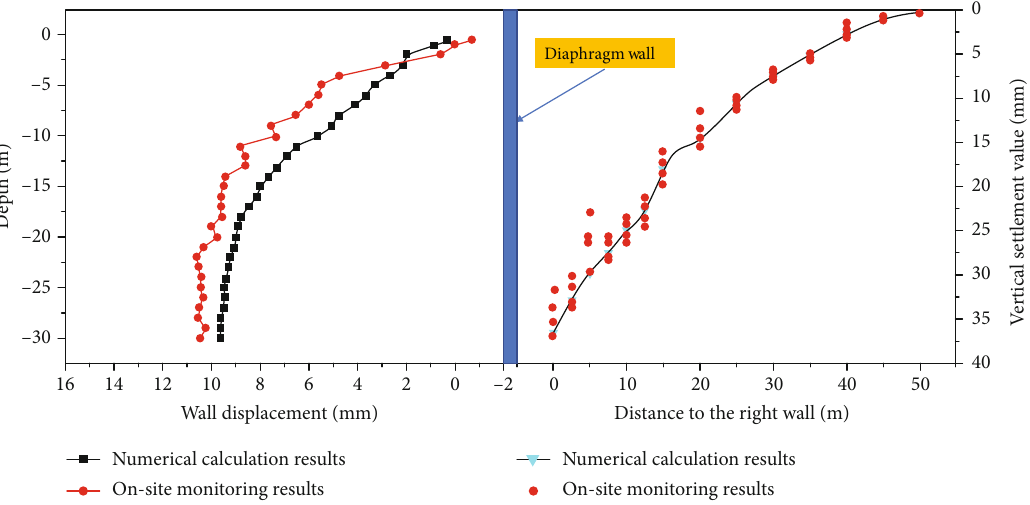
Figure 14: Comparison of displacement of underground continuous wall and wall thickness